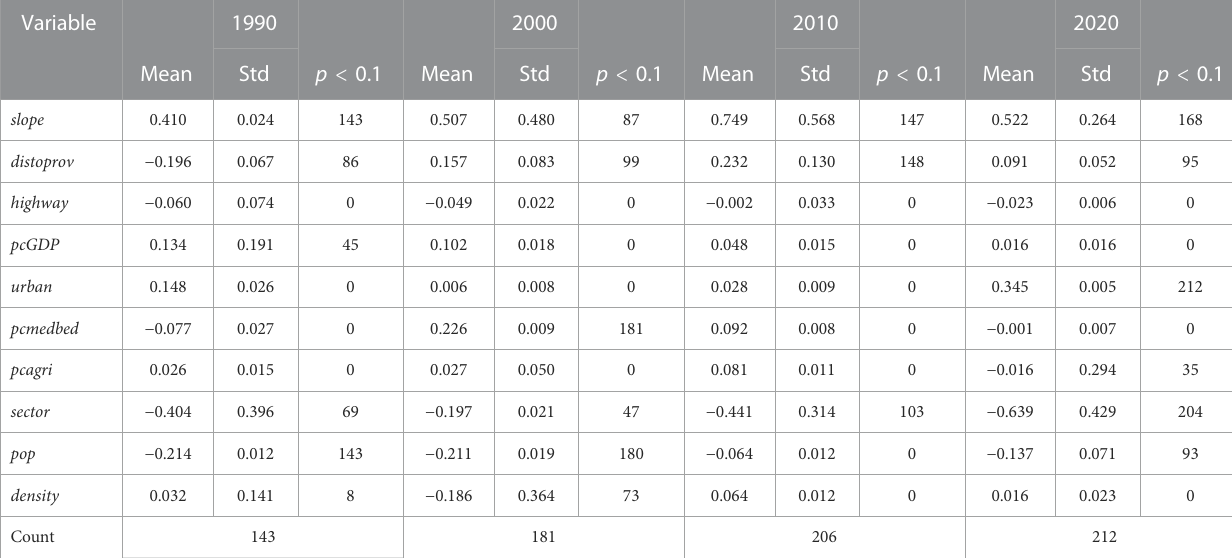
TABLE 5 Analysis of the factors in fl uencing intra city-size distribution by MGWR.